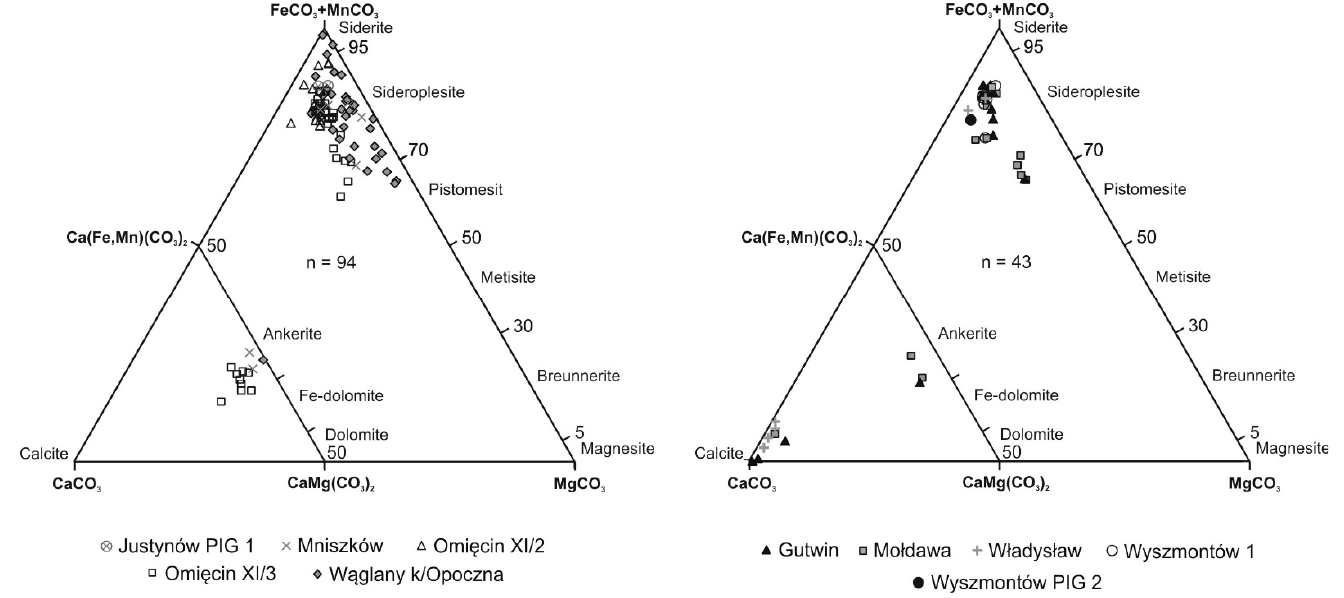
Figure 4. Ternary plot of the carbonates composition in mol %; n —analysis